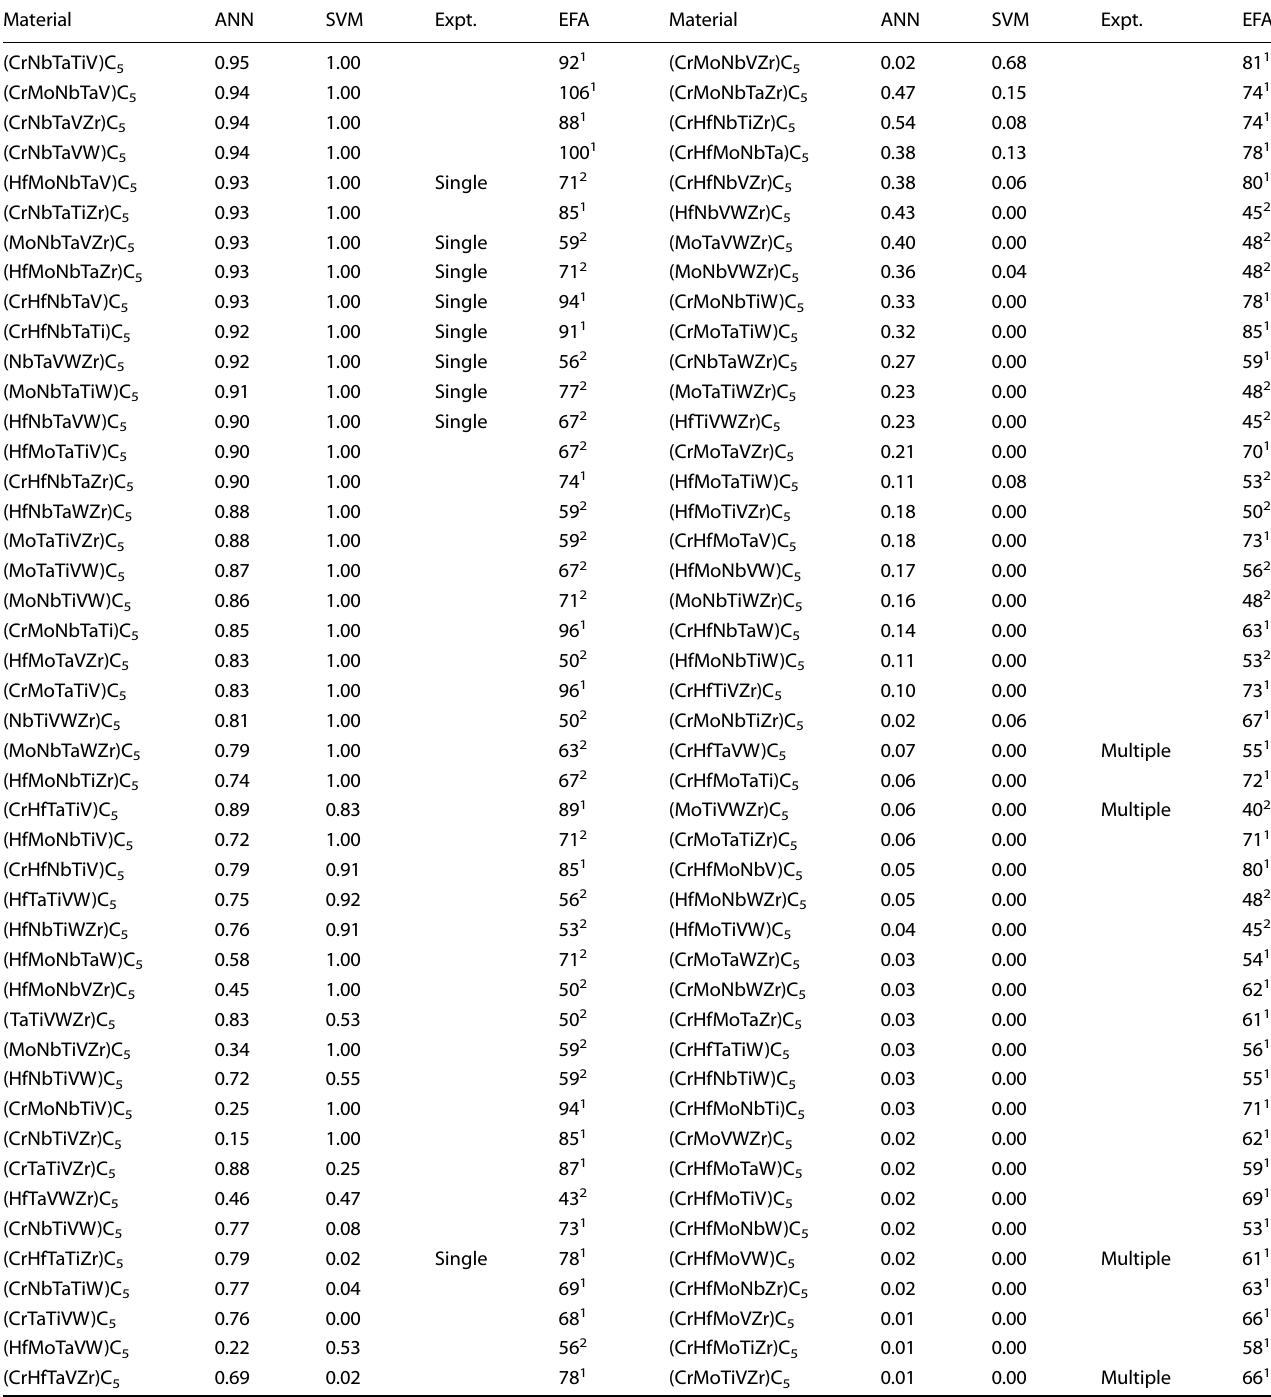
Table 2. Results predicted by current ML